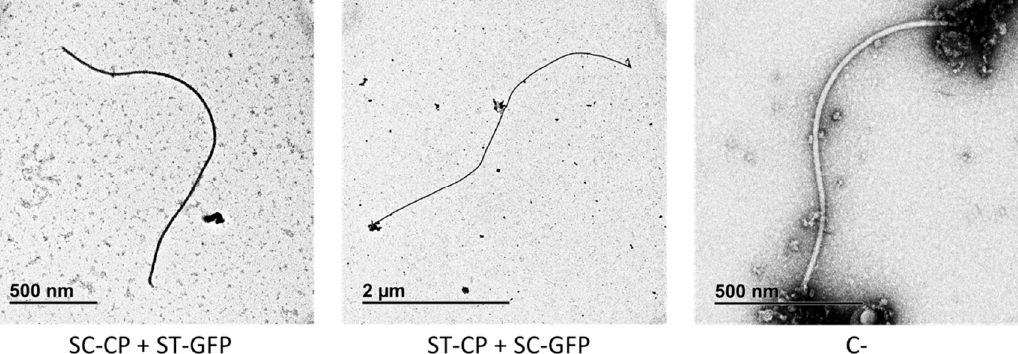
Figure 4. Representative TEM micrographs of the two co-agroinfiltrated constructs of TuMV VLPs- GFP using the SpyTag/SpyCatcher conjugation technology (SC-CP + ST-GFP and ST-CP + SC-GFP). VLPs treated with primary anti-GFP antibody are on the left and central panels. ST: SpyTag; SC: SpyCatcher; CP: TuMV capsid protein; GFP: green fluorescent protein; C-: negative control of an eVLP (ST-CP + SC-GFP) without treatment with the primary anti-GFP antibody.